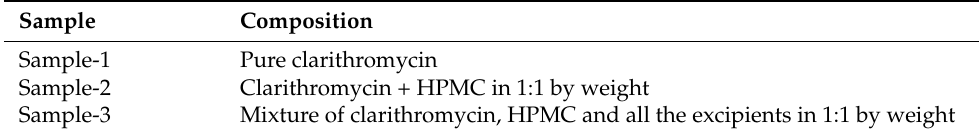
Table 1. Composition of samples used in drug excipient compatibility test.